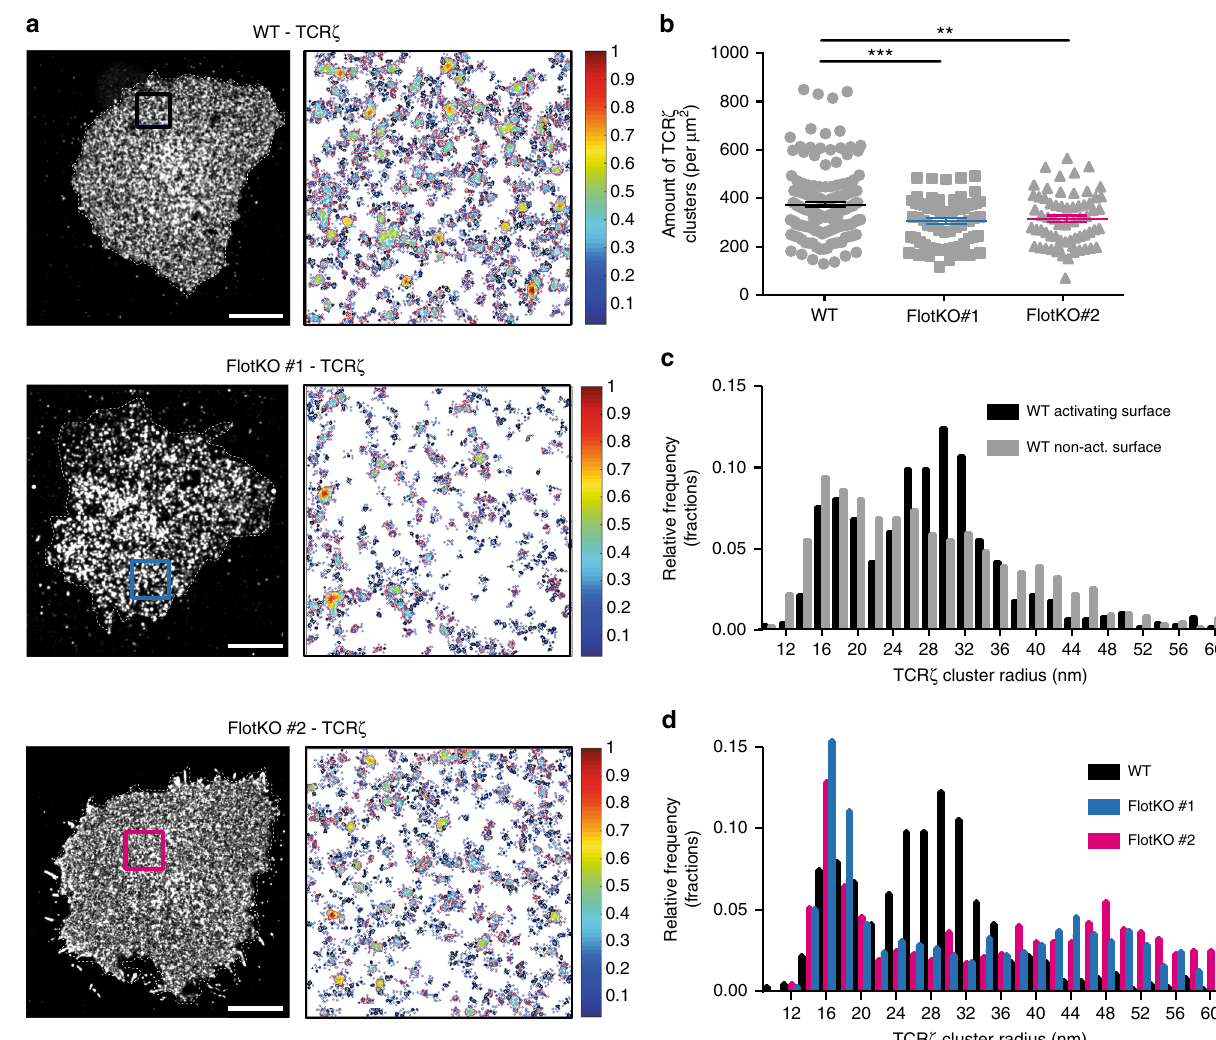
Fig. 6 Flotillin-mediated TCR recycling controls TCR ζ cell surface nanoscale organization. a Left: Representative single-molecule images of TCR ζ -PSCFP2 in WT (top) and fl otillin1/2 KO (bottom) Jurkat T cells on activating anti-CD3 ε and anti-CD28 antibodies coated glass surfaces. Right: cluster maps color- coded for the relative molecular density from regions (3 µ m × 3 µ m) highlighted in the single-molecule images (boxes); normalized relative density is pseudocoloured. b Number of TCR ζ -PSCFP2 clusters per µ m 2 identi fi ed by DB-SCAN, in WT and fl otillin1/2 KO Jurkat T cells. c TCR ζ -PSCFP2 cluster size distribution in WT Jurkat T cells on non-activating (anti-CD90 antibodies; grey) and activating (anti-CD3 ε and anti-CD28 antibodies; black) coated glass surfaces. d TCR ζ -PSCFP2 cluster size distribution in WT and fl otillin1/2 KO Jurkat T cells on activating (anti-CD3 ε and anti-CD28 antibodies) coated glass surfaces. Scale bars, 5 µ m. Data obtained from three or more independent experiments, with at least fi ve cells per experiment. Error bars indicate mean (±SEM). ns, not signi fi cant; ** p < 0.001; *** p < 0.0001; Mann – Whitney t